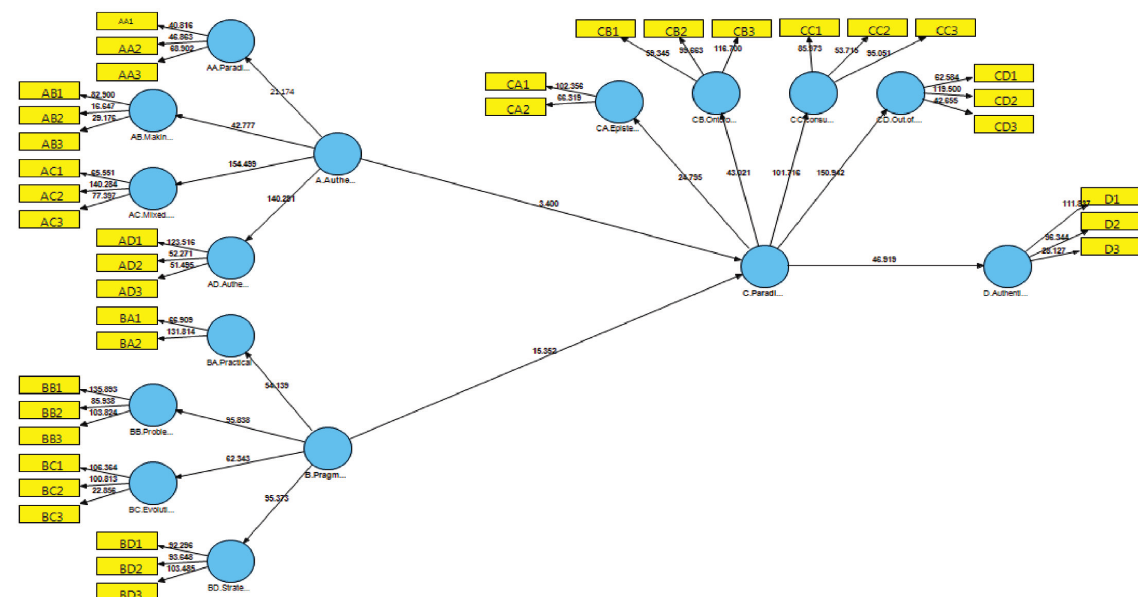
Figure 3: The external model of first-order hypotheses in general significance